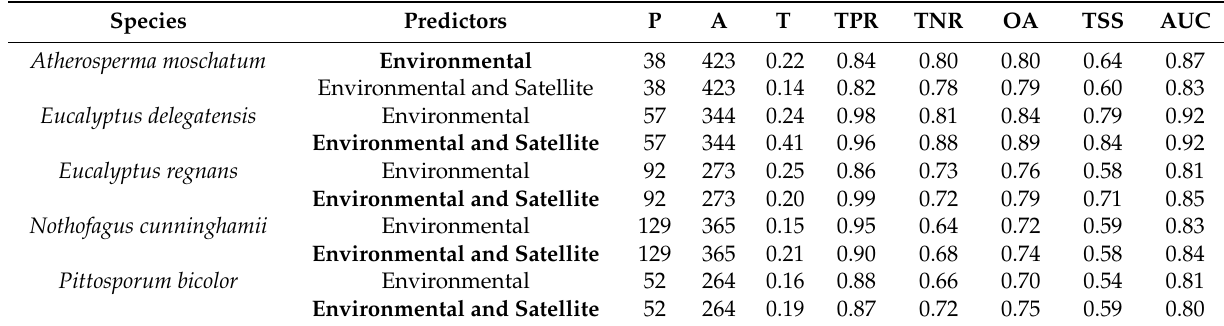
Table 3. Cross-validated (spatially blocked across six folds) random forest species distribution models for species used to delineate stand types in the Central Highlands region. Model variants selected for predictive ecosystem mapping are bolded for each